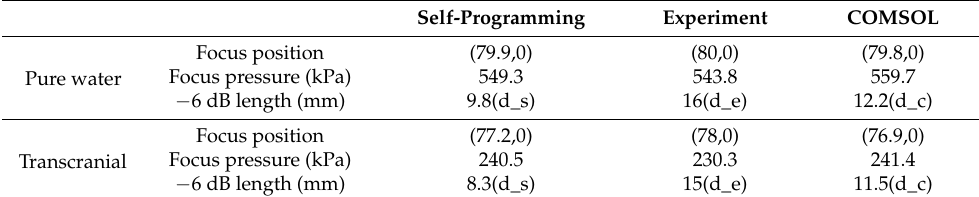
Table 2. Comparison of pure water and transcranial